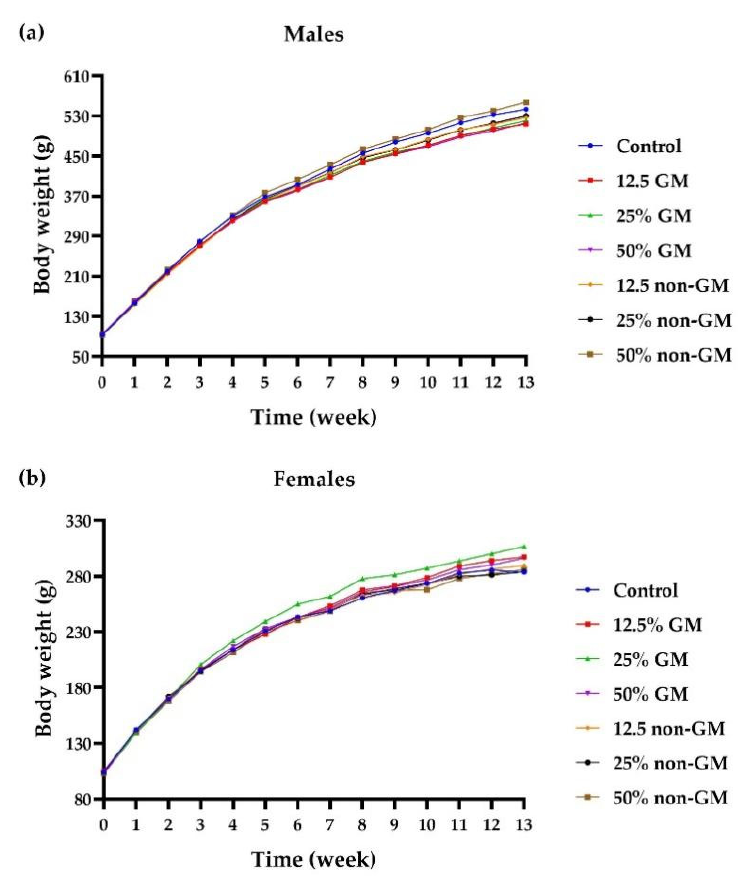
Figure 2. Body weight of rats during 13 weeks.: ( a ) mean weekly body weight of rats for male; ( b ) mean weekly body weight of rats for